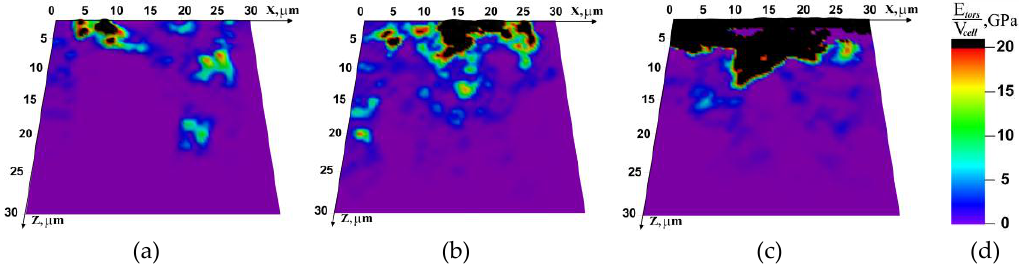
Figure 6. Specific rotation energy distribution on specimen faces at different temperatures at 500 μs after the beginning of loading. ( a ) −60 °C; ( b ) −20 °C; ( c ) 20 °C; ( d ) color legend.